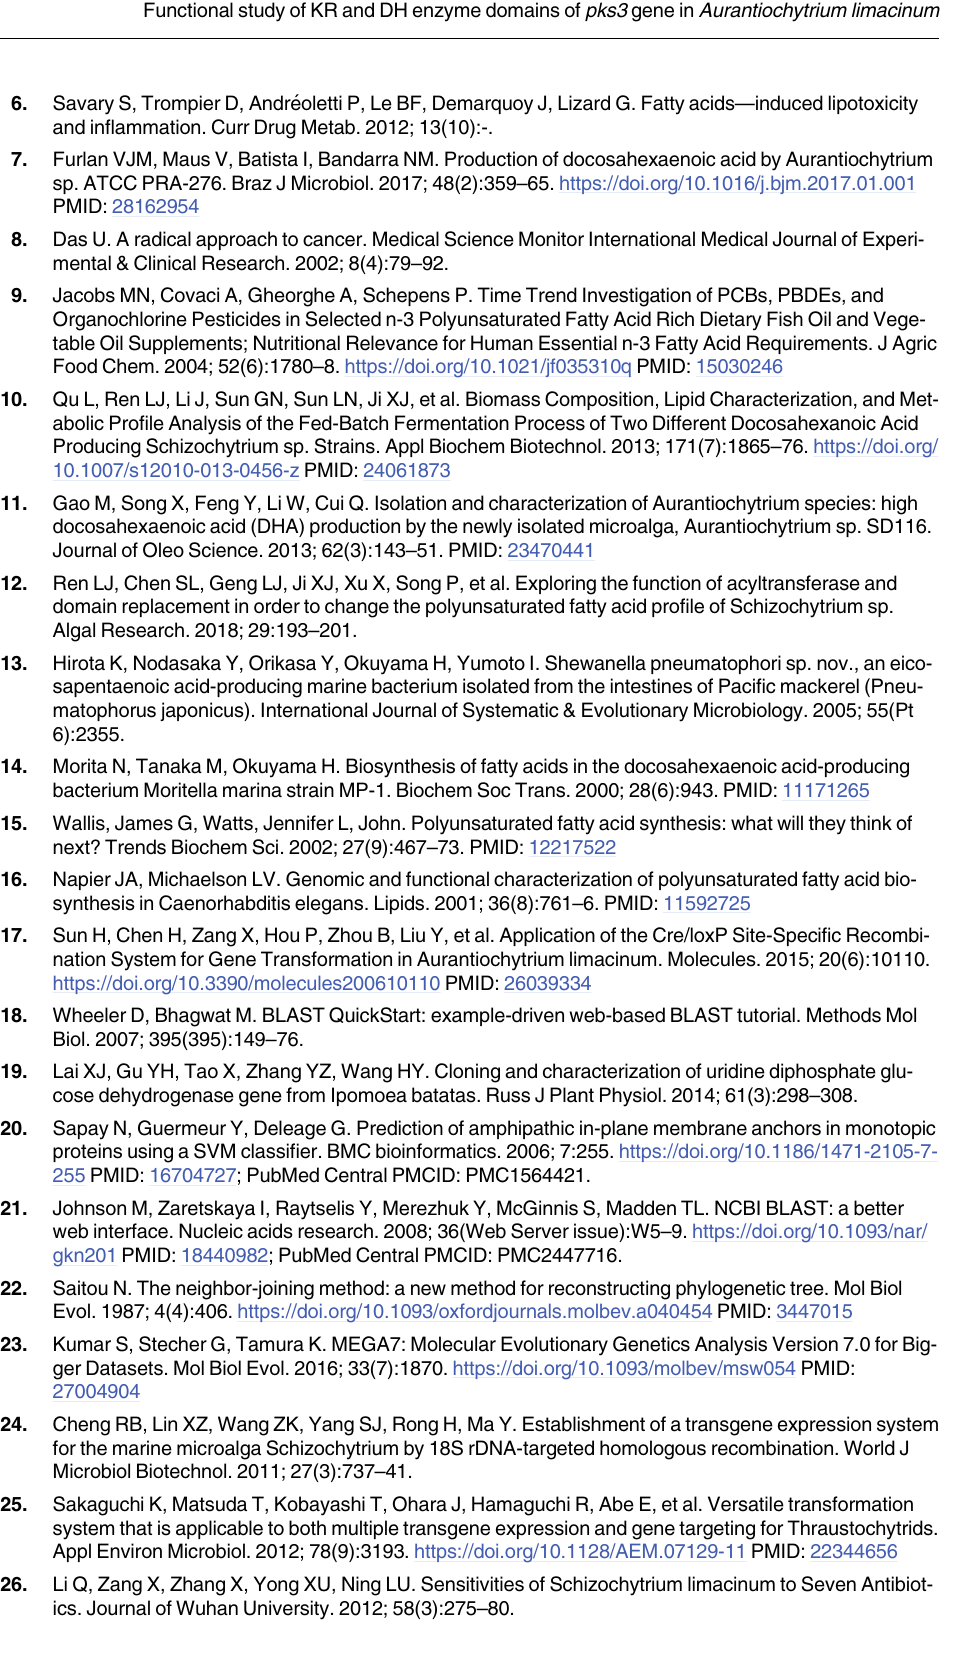
table Oil Supplements; Nutritional Relevancefor Human Essentialn-3 Fatty Acid Requirements. J Agric Food Chem. 2004; 52(6):1780–8. https://doi.org/10.1021/jf035310q PMID: